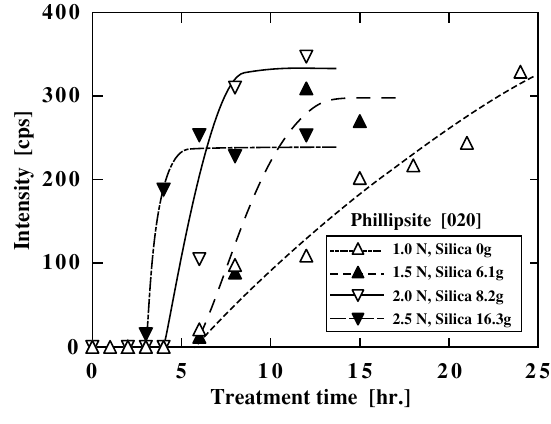
Fig. 12 Change in phillipsite peak intensity of products with treatment time for various NaOHaq. concentrations (Fly ash + Silica powder =